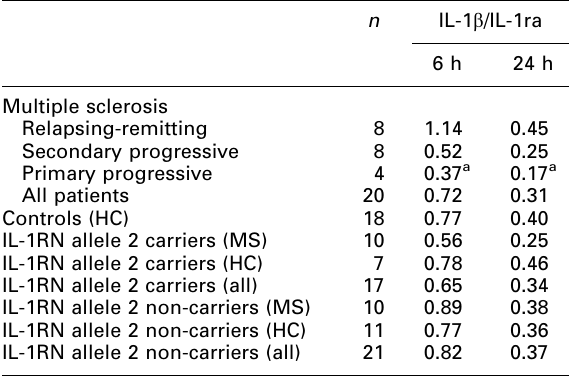
IL-1RN allele 2 carriers, IL-1RNallele 2 (cid:2) / /IL-1B (cid:2) 3959 allele 2 (cid:3) / ; IL-1RN allele 2 non-carriers, IL-1RN allele 2 (cid:3) / /IL-1B (cid:2) 3959 allele 2 (cid:3) / ; HC (cid:4) / healthy controls. a Primary progressive versus relapsing-remitting (p (cid:4) / 0.038 and p (cid:4) / 0.017, 6 and 24 h; Mann (cid:1) / Whitney